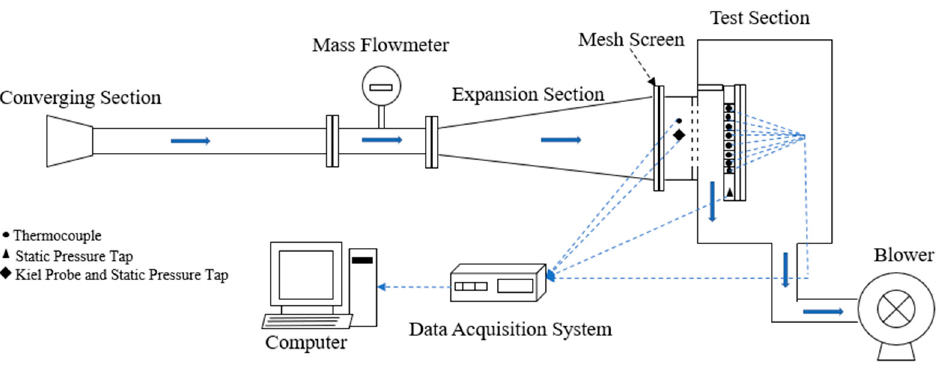
Figure 1. Impingement cooling test facility.